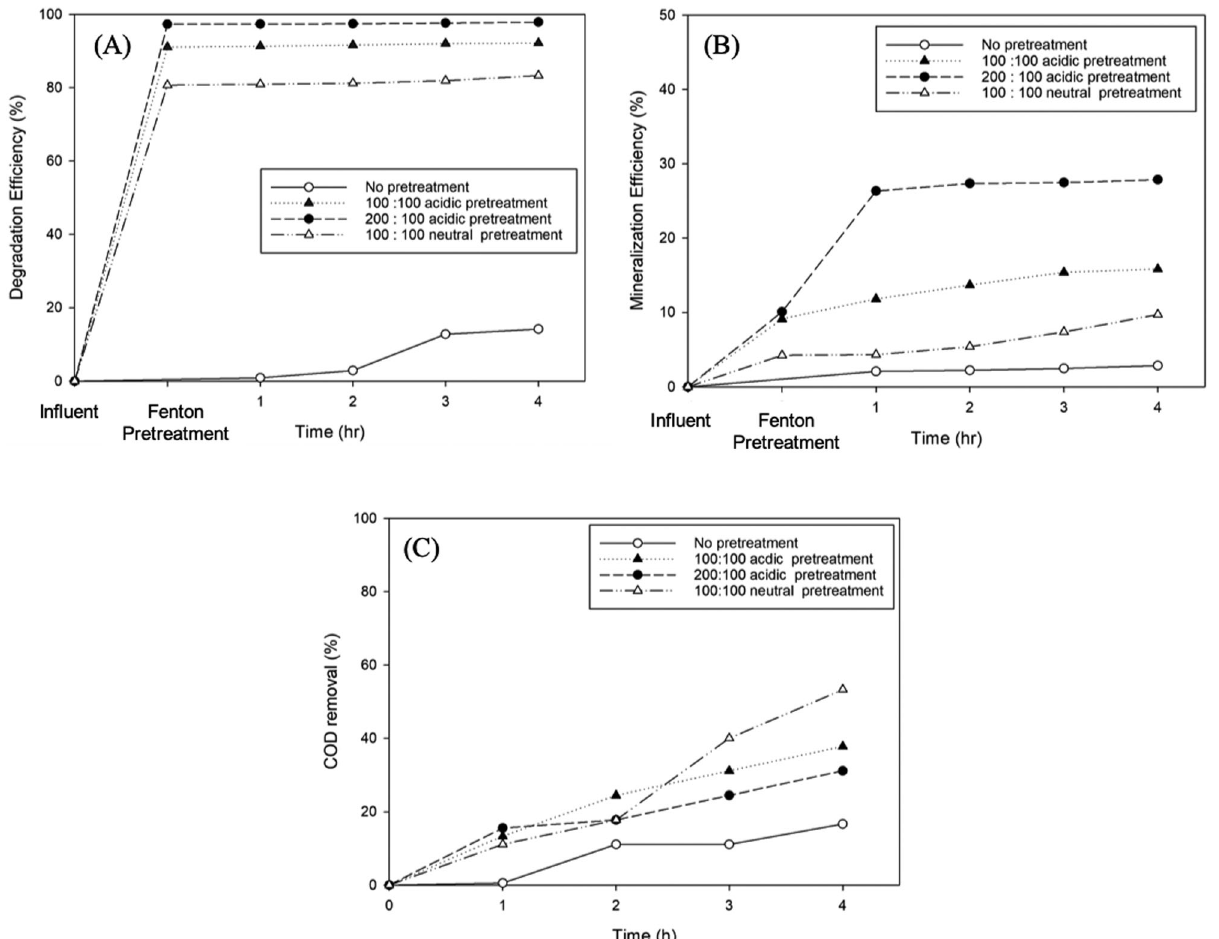
Fig. 4 The removal of CBZ by the hybrid system. The A degradation, B mineralization, and C COD removal ef fi ciencies of CBZ by combined Fenton pretreatment and activated sludge